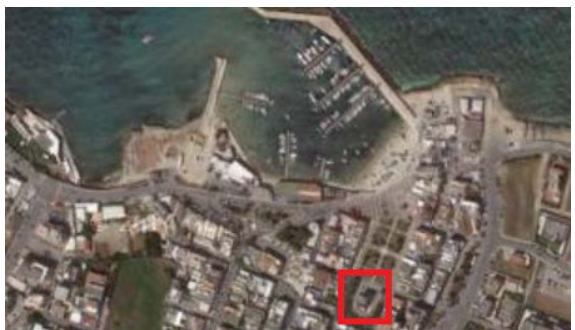
Figure 1: The tower location (Google